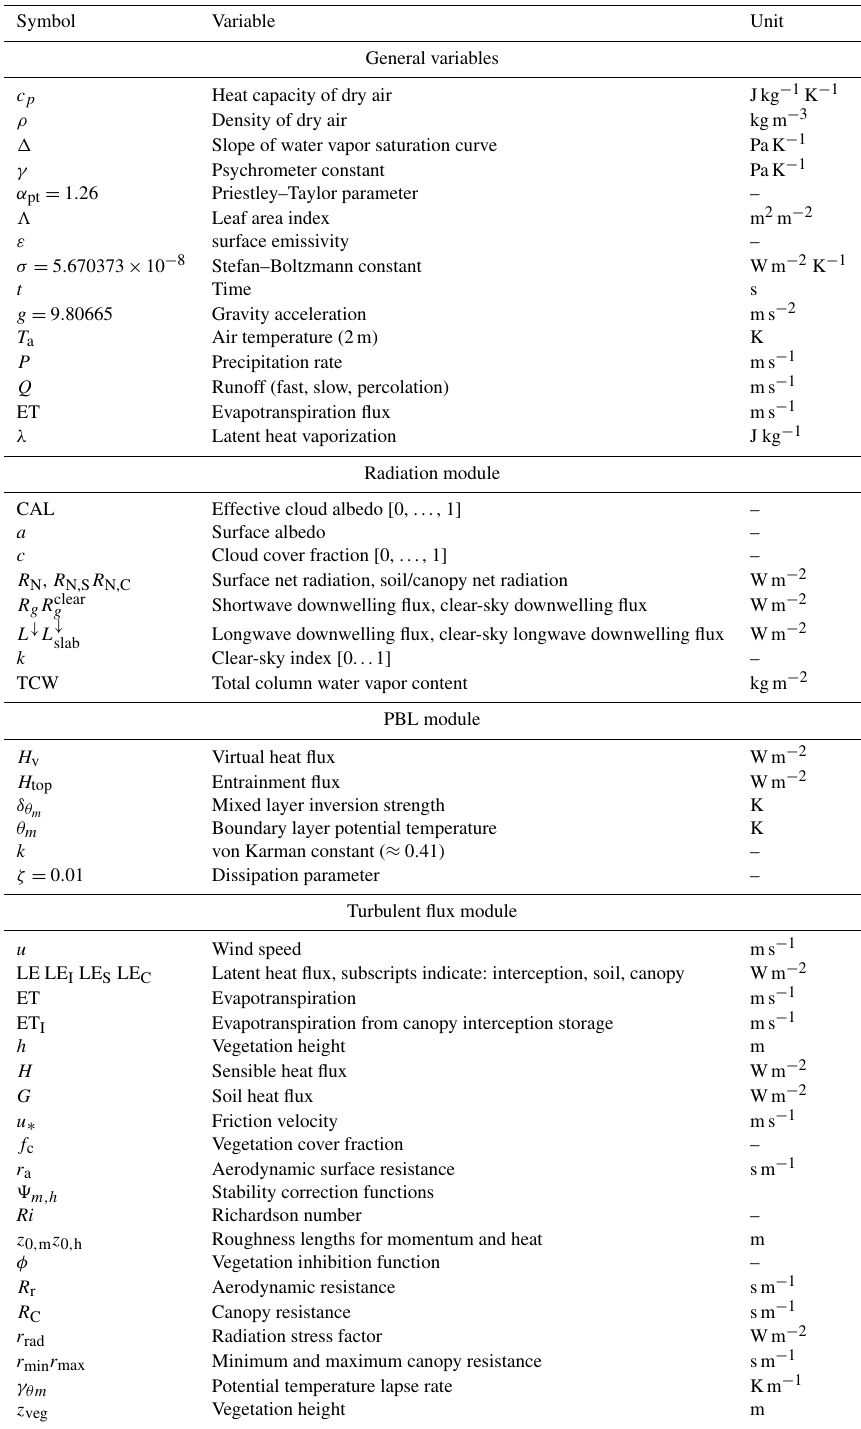
Table A1. Acronyms used throughout the